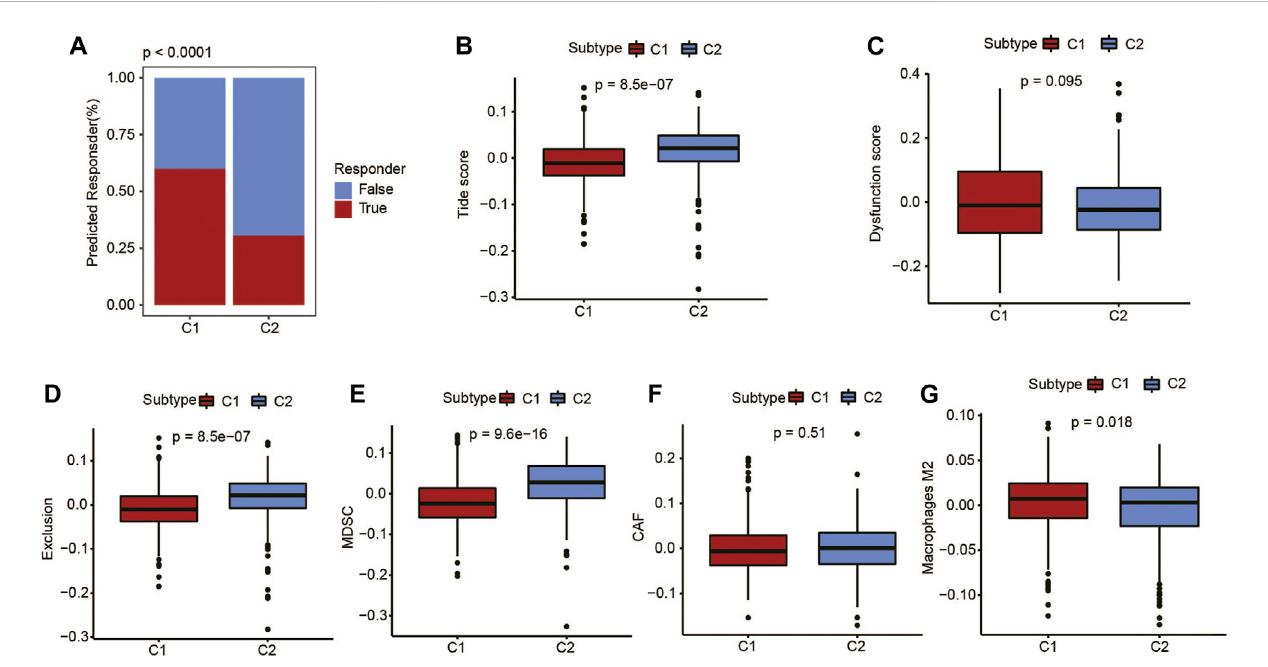
FIGURE 4 Immunotherapy prediction of UCEC patients using the TIDE algorithm. (A) Difference in response to immunotherapy among different metabolic subtypes. (B) TIDE score, (C) dysfunction score, (D) exclusion score, (E) myeloid-derived suppressor cell (MDSC) score, (F) cancer-associated fi broblast (CAF) score, and (G) M2-macrophages